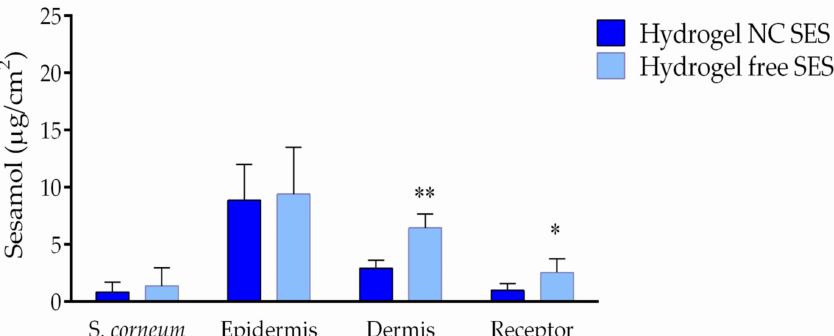
Figure 8. Ex vivo permeation profile of the hydrogels containing sesamol in the free (Hydrogel free SES: light-blue column) or nanoencapsulated forms (Hydrogel NC SES: blue column) after